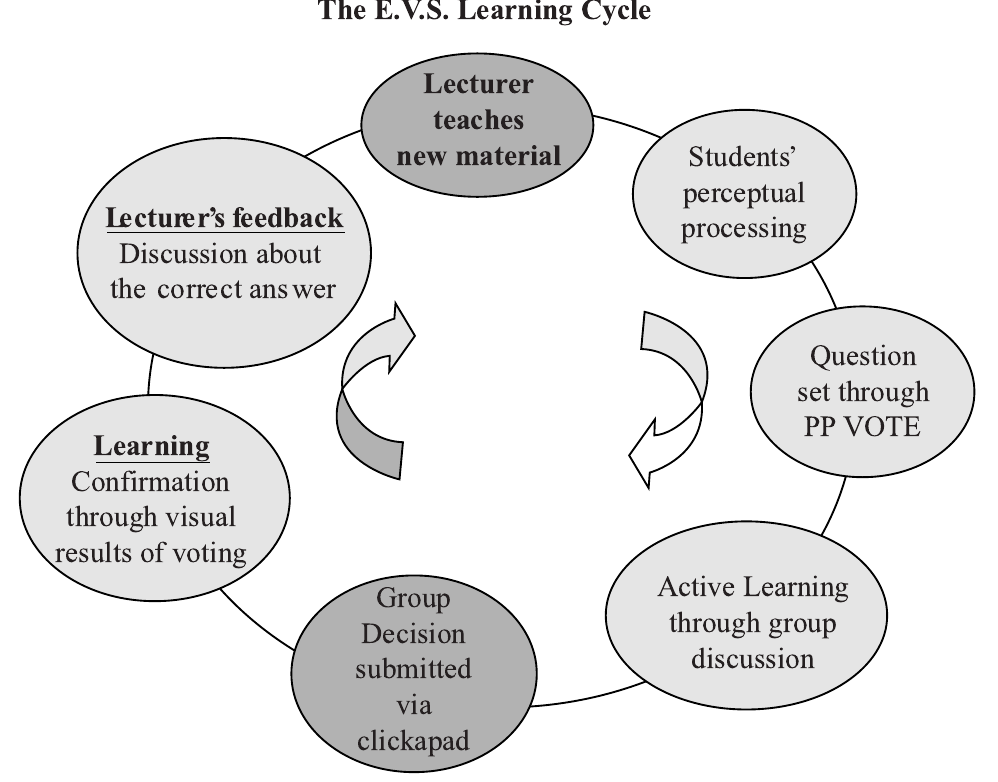
Figure 1. The EVS learning cycle and